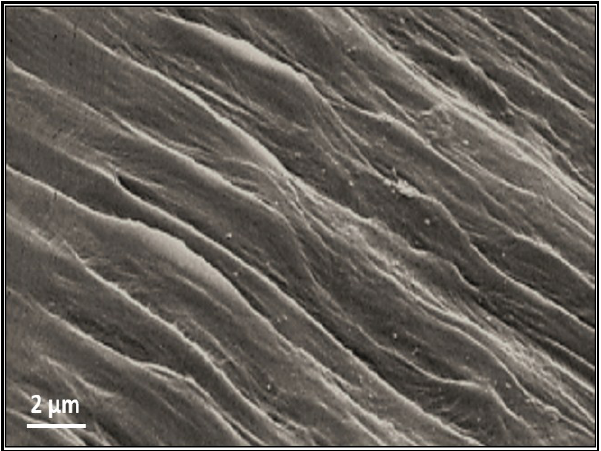
Figure 10. Secondary electron SEM image of the beeswax-colophony blend surface after being immersed in the UASBR treatment plant for a